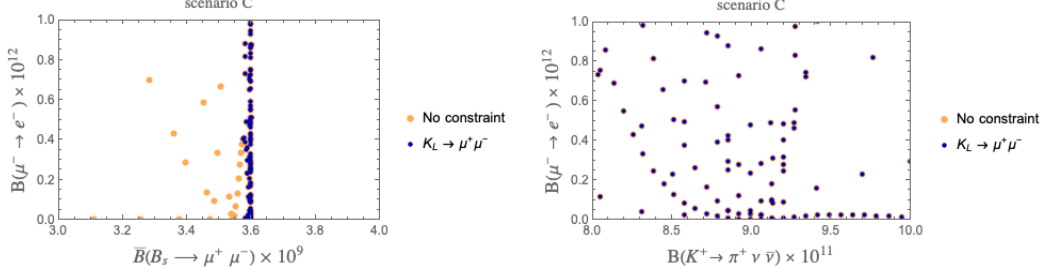
Figure 18 . Scenario C. Correlations between B ( (cid:22) (cid:0) ! e (cid:0) ) and (cid:22) B ( B s ! (cid:22) + (cid:22) (cid:0) ) (left panel) and between B ( (cid:22) (cid:0) ! e (cid:0) ) and B ( K + ! (cid:25) + (cid:23) (cid:22) (cid:23) ) (right